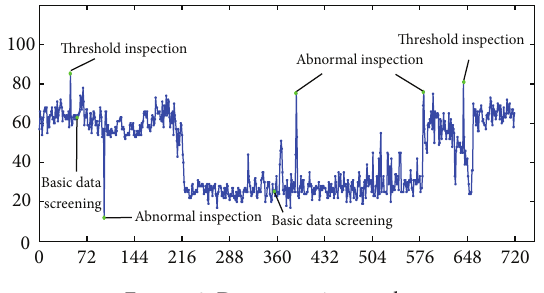
Figure 3: Data screening